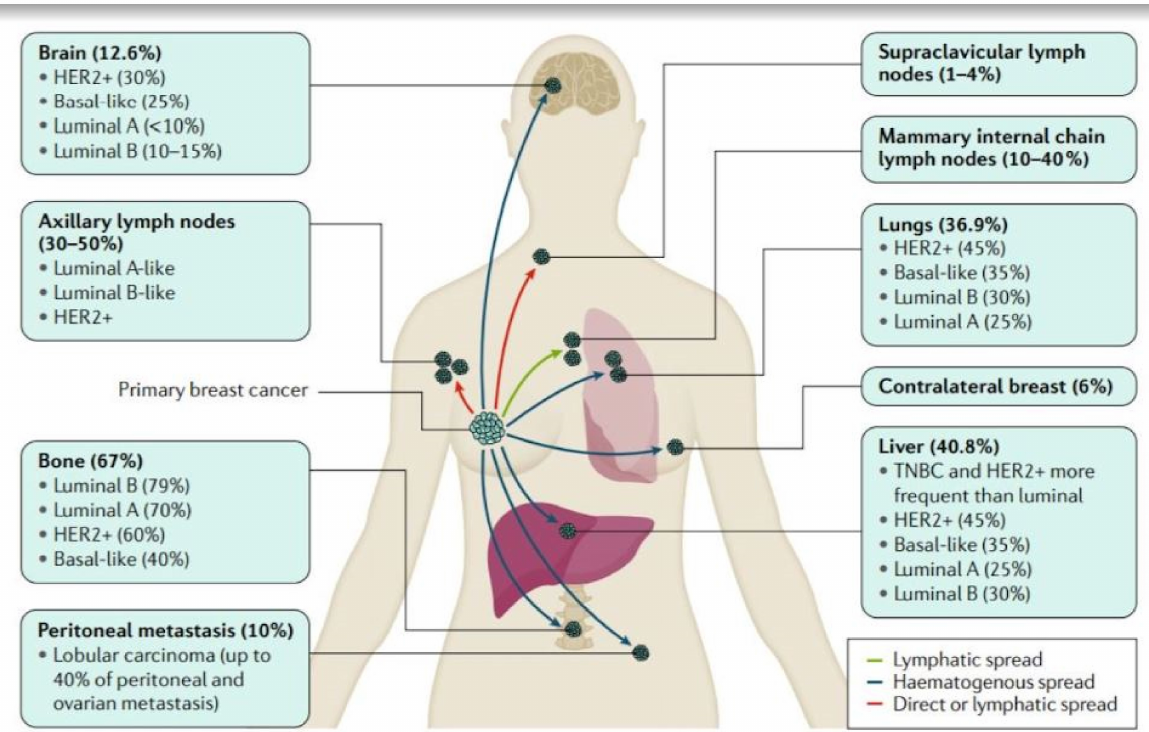
Figure 2. Illustration of common metastatic sites in breast cancer [2]. The most common metastatic sites for breast cancer are the bones, axillary lymph nodes, liver, and lungs. Approximately 10–40% of breast cancer tumors have metastasized in the internal mammary gland. Breast cancer can advance to distant metastatic sites depending on the molecular subtype; for example, Luminal A, B, HER2+, triple negative breast cancer (TNBC), or basal-like breast cancer. Locoregional lymphatic spread is sparse in TNBC compared to other subtypes, while brain metastases are more frequent in TNBC compared to luminal tumors